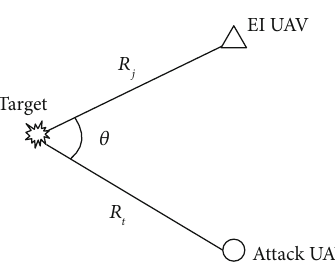
Figure 1: Schematic diagram of electronic interference process